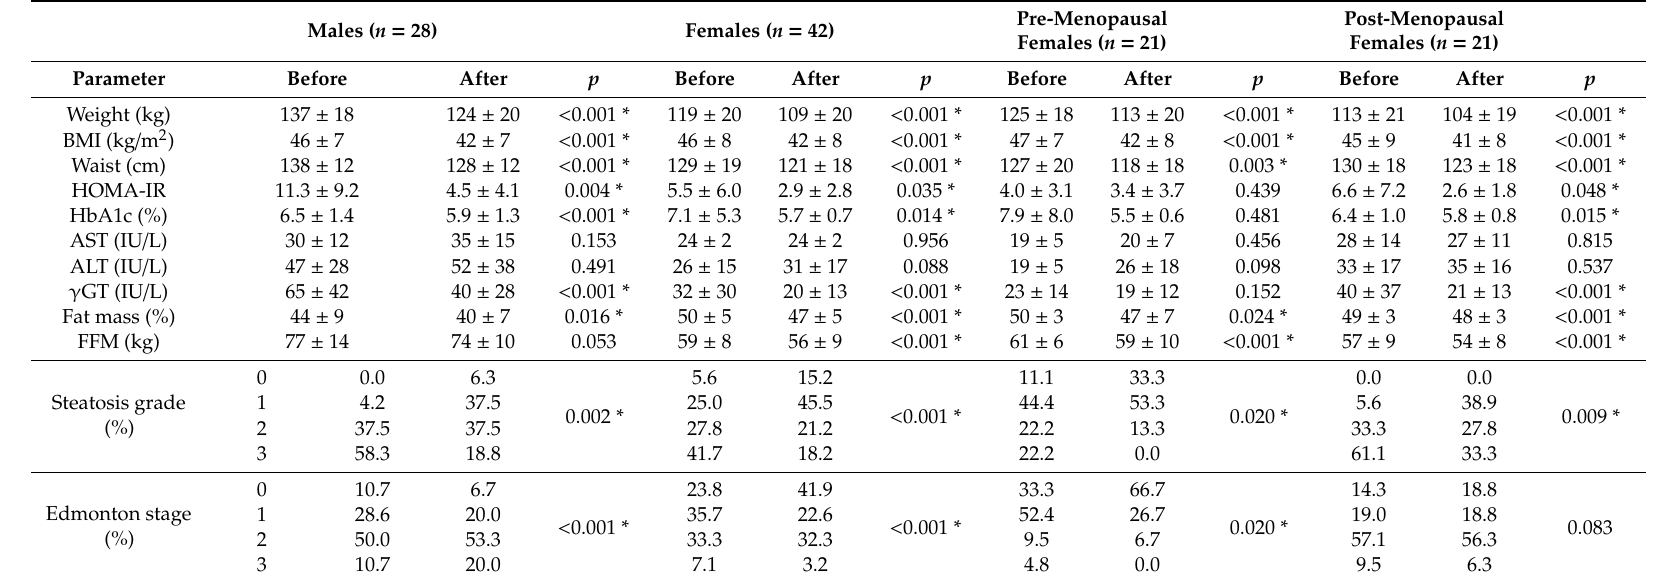
Table 3. Variations of the clinical, anthropometric, bioimpedentiometric, biochemical, and ultrasonographic parameters before and after following the very low-carbohydrate ketogenic diet (VLCKD), according to sex and menopausal status (Student’s paired t -test and Wilcoxon